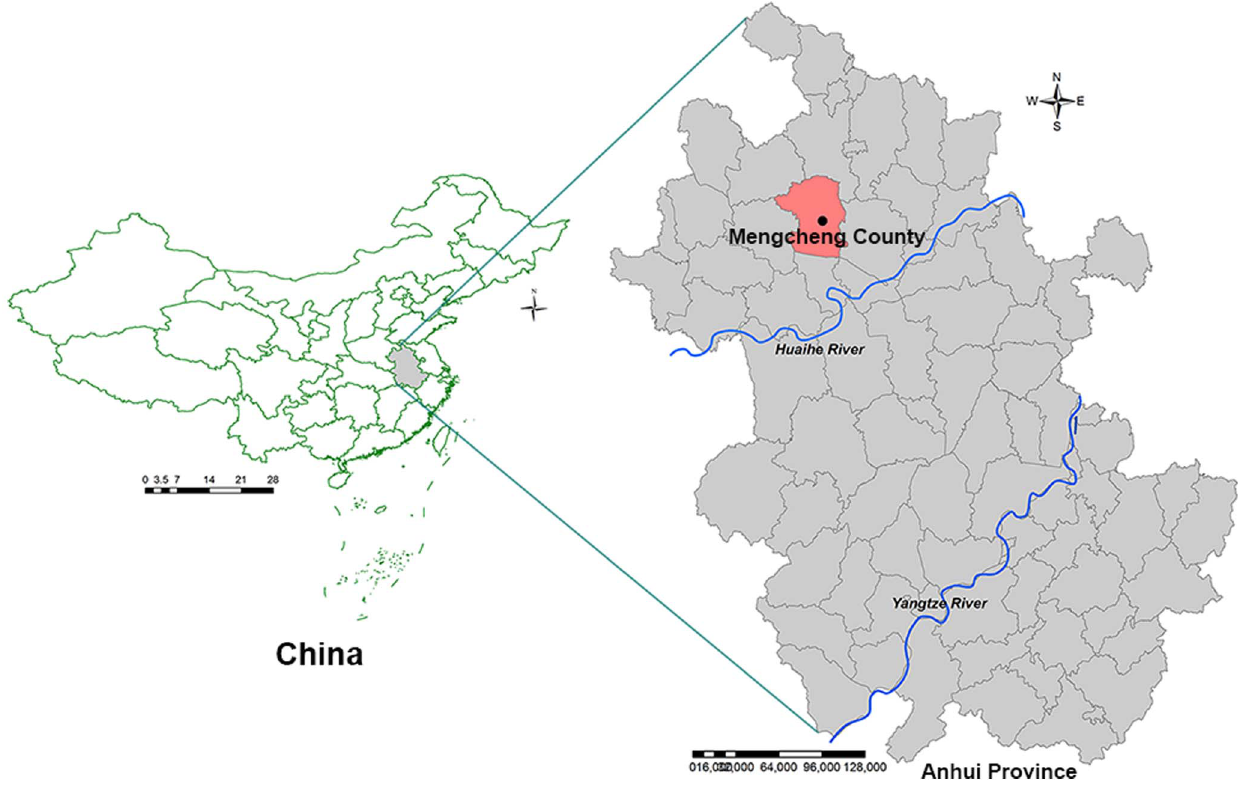
Figure 2. Location of the study area in Anhui Province, China.